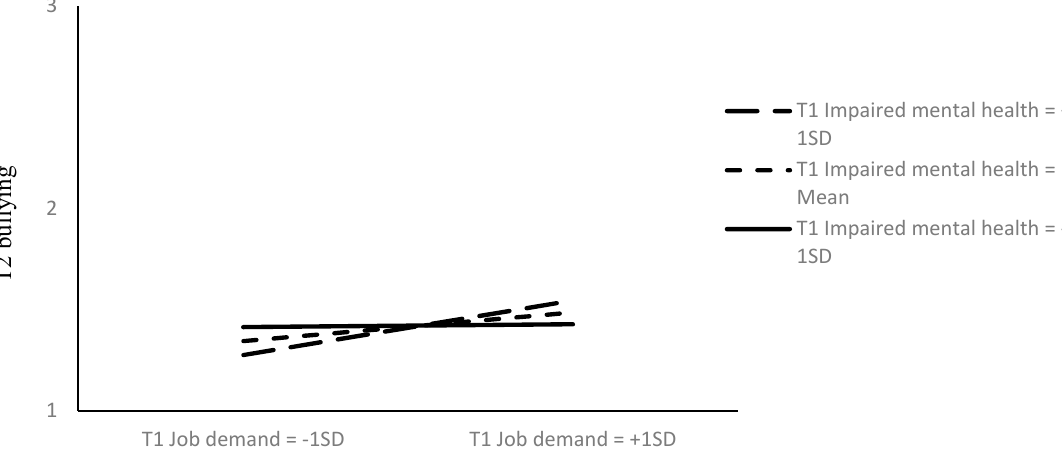
Figure 3. Interaction between T1 job demand and T1 impaired mental health in the prediction of T2 bullying. Note. SD = standard deviation.